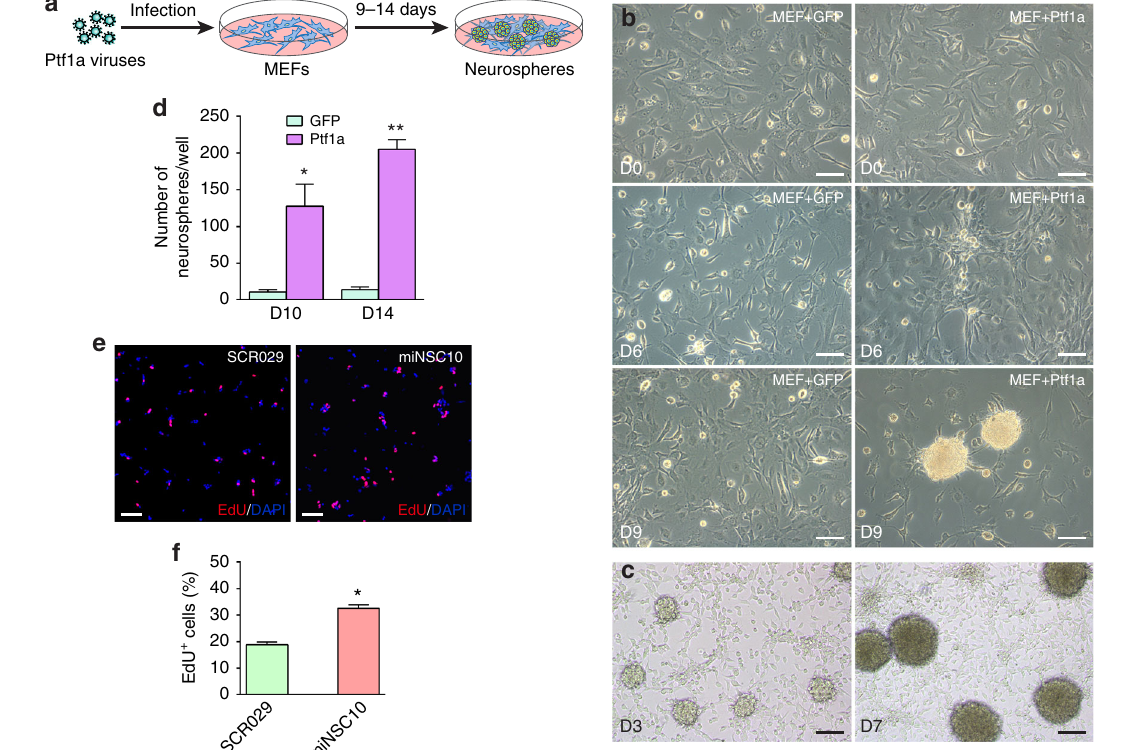
Fig. 1 Ptf1a directly converts mouse embryonic fi broblasts (MEFs) into self-renewable neurospheres. a Schematic depicting the procedure to generate neurospheres from MEFs by Ptf1a lentiviruses. MEFs were prepared from E12.5 C57BL6/J mouse embryos and infected with tet-on Ptf1a lentiviruses at day 0. Neurosphere-like structures gradually appeared in 9 – 14 days when cultured in N3 medium containing EGF, bFGF, and doxycycline. b Morphological changes of MEFs infected with control GFP or Ptf1a lentiviruses. Numerous cell clusters could be seen in Ptf1a virus-infected MEFs by day 6 in culture, but rarely in GFP virus-infected MEFs. From day 9 onward, many typical neurosphere-like structures formed in Ptf1a-transduced MEFs, whereas in GFP- transduced MEFs there were only few cell aggregates, which were morphologically different from typical neurospheres. c Dissociated cells from collected primary neurospheres formed secondary neurospheres in 3 days in culture and morphologically homogeneous larger neurospheres by day 7. d Quanti fi cation of Ptf1a-induced neurospheres. MEFs (4 × 10 4 ) were seeded into each well of 12-well plates, infected with Ptf1a or GFP viruses, and neurosphere-like structures in each well were then counted at day 10 and 14 following virus infection. There were signi fi cantly more neurospheres in Ptf1a- induced samples at day 10 and 14. Data are presented as mean ± SD ( n = 3). Asterisks indicate signi fi cance in unpaired two-tailed Student ’ s t -test: f Quanti fi cation of EdU-labeled cells. Higher percentage of proliferative cells was found in miNSC10 than in control SCR029 NSCs. Data are presented as mean ± SD ( n = 3). The asterisk indicates signi fi cance in unpaired two-tailed Student ’ s t -test: * P < 0.0001. Scale bars, 80 μ m ( b ), ( e ) and 93.1 μ m ( c